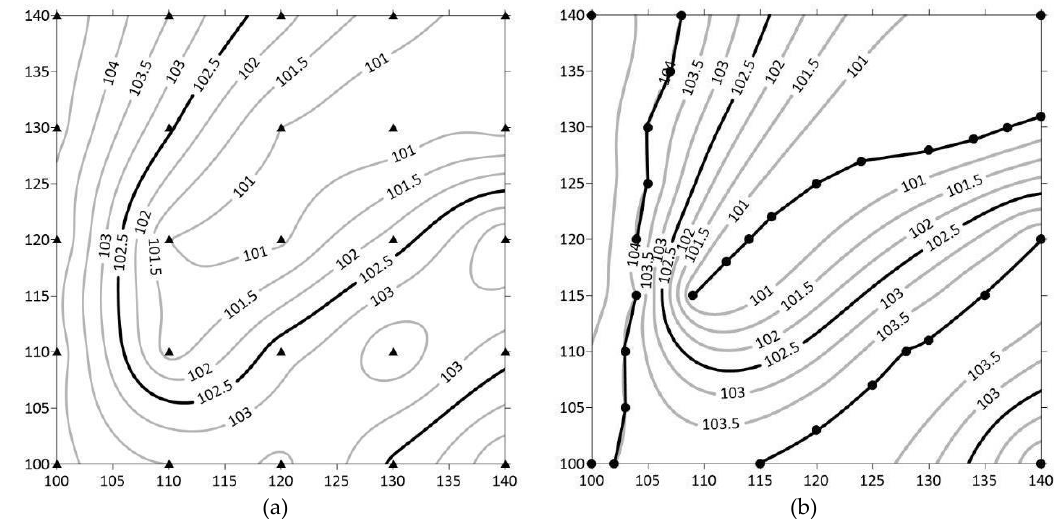
Figure 5. Sample of regular terrain model contours ( a ) and those who are generated from structural lines sampling ( b ) .